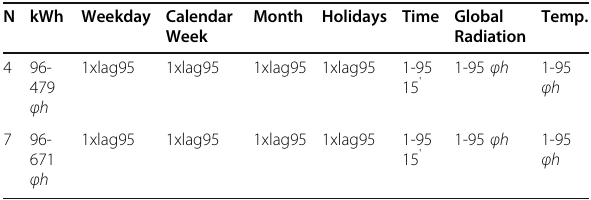
Table 1 (abstract P5). Best Combination of lagged input values